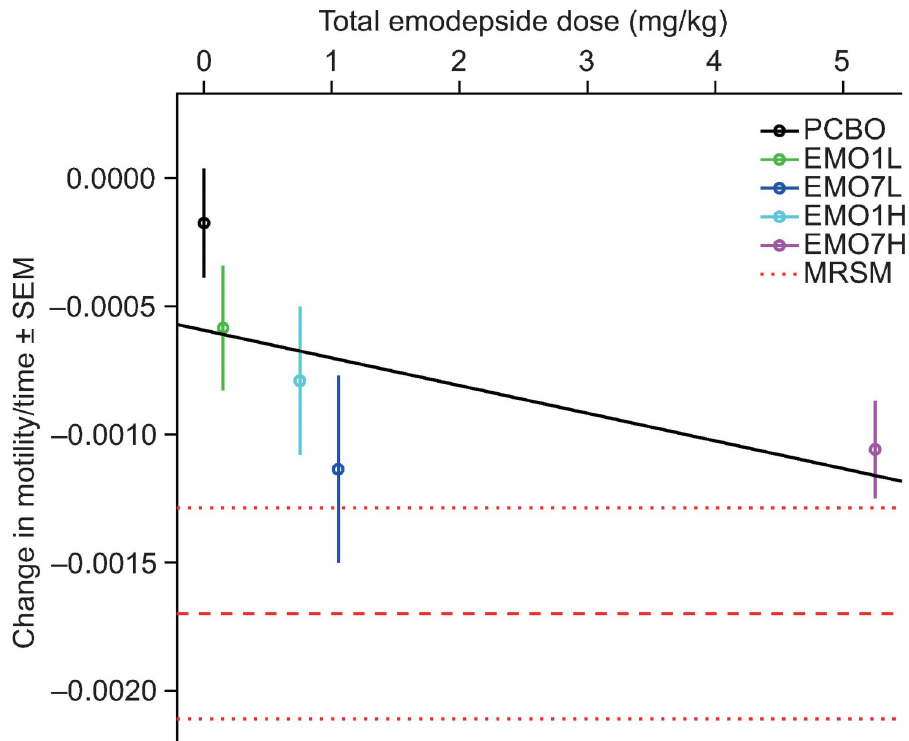
Fig 8. Linear model describing the relationship between change in adult female worm ( Onchocerca ochengi ) motility over time and total emodepside dose. The anterior end of the female worm was removed from the worm mass and incubated alongside intact male worms for 30 min at 37˚C for visual motility assessment on a three-point scale [59]. A linear model of worm motility over time for a given treatment group was estimated and repeated for each group; the slope β for each group is reported in this figure. The null hypothesis was β = 0, and t statistics were used to test and reject the null hypothesis and to estimate the P value. Datapoints are mean values and error bars represent SEM. Dashed lines in red indicate the mean ± SEM for the positive control (MRSM). A regression model of the relationship between dose and decrease in motility (black line) indicated there was a non-significant trend between dose and treatment effect. EMO1H, emodepside, 0.75 mg/kg, single dose; EMO7H, emodepside, 0.75 mg/kg, daily for seven days; EMO1L, emodepside, 0.15 mg/kg, single dose; EMO7L, emodepside, 0.15 mg/kg, daily for seven days; MRSM, melarsomine, 4 mg/kg, every other day for three days; PCBO, placebo; SEM, standard error of the